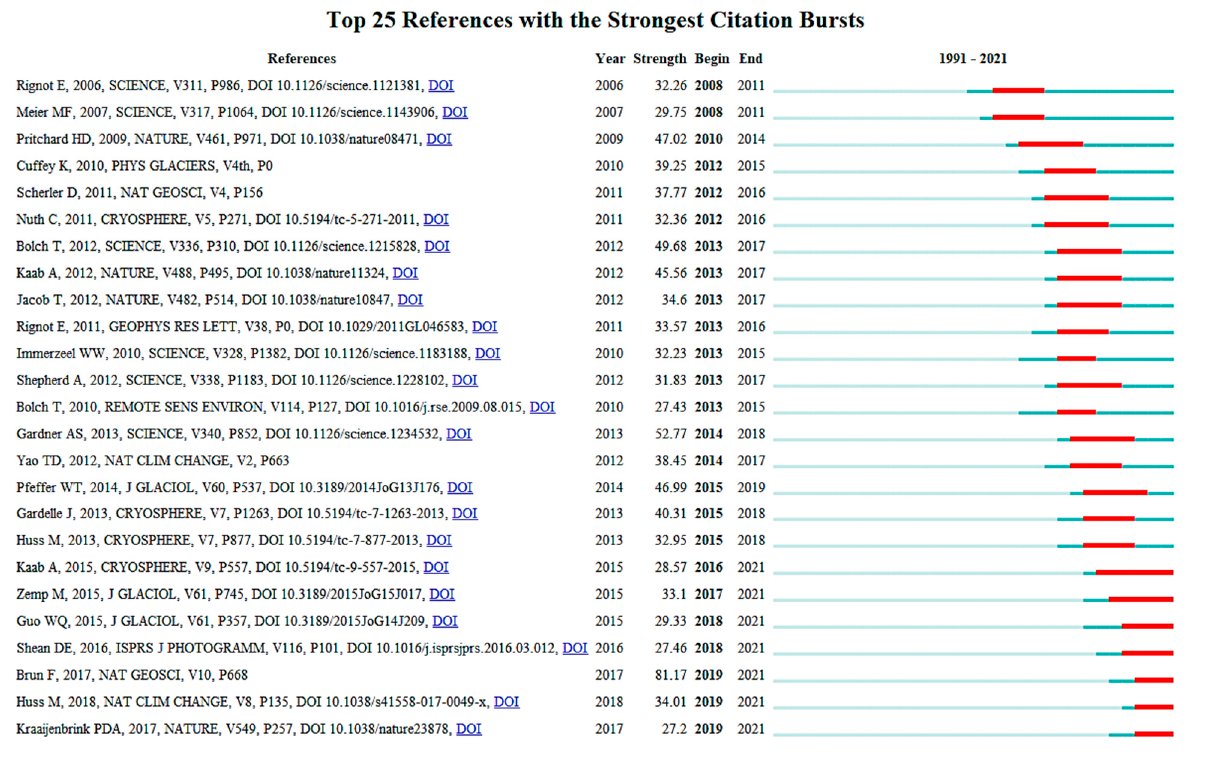
Table 8. Top 10 high-frequency keywords.